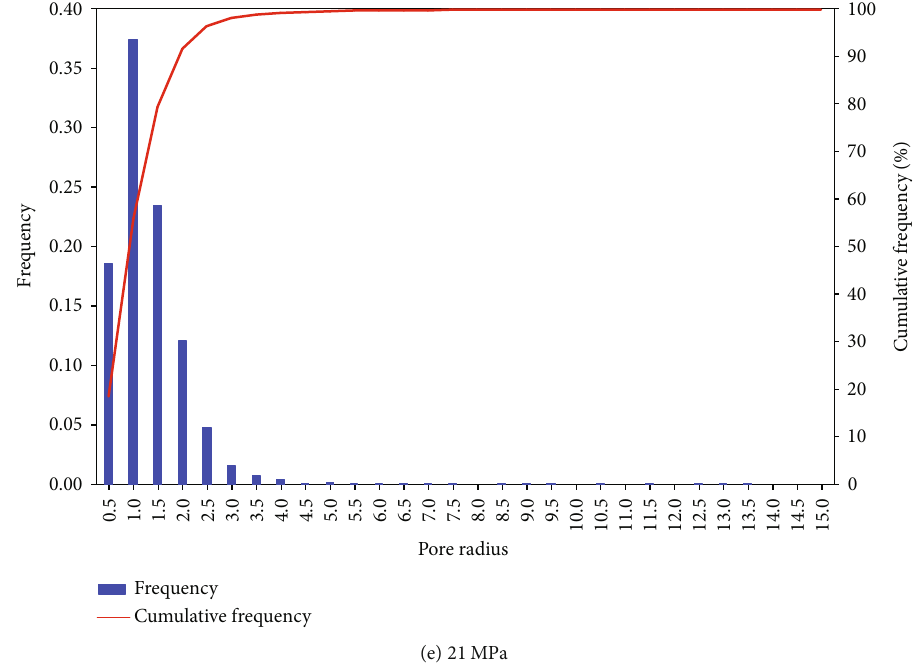
Figure 13: Frequency distribution of pore radii for simulated deformed digital